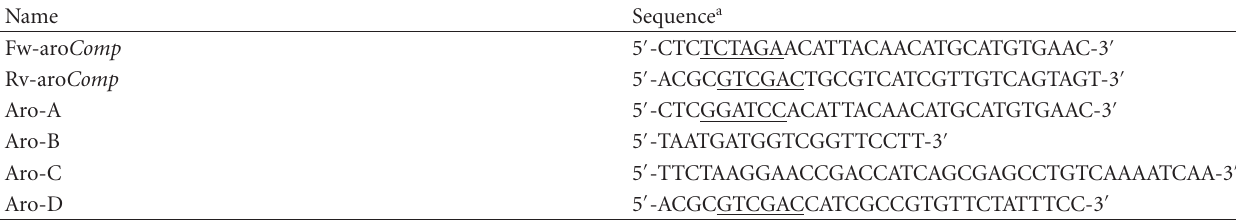
Table 2: Primers used in this